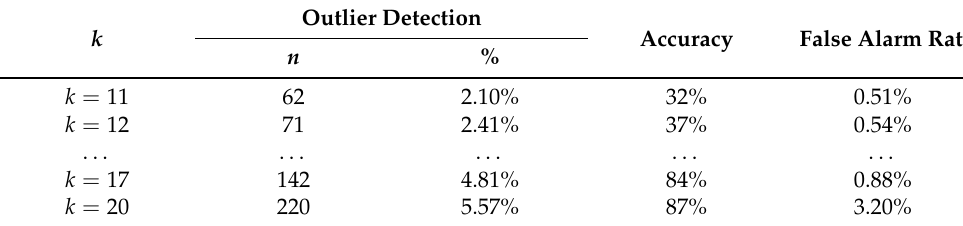
Table 3. Outlier detection analysis for different k